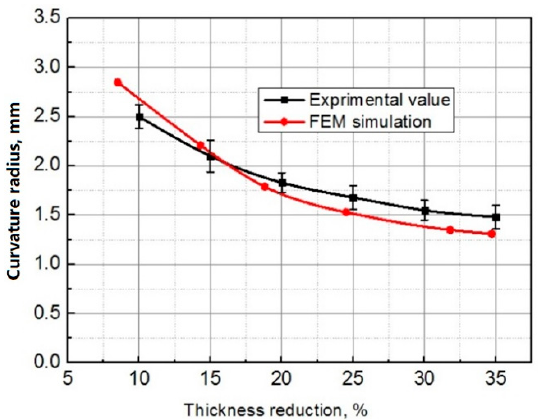
Figure 12. Barreling radius as obtained in the simulations and experiment (1 mm in diameter).